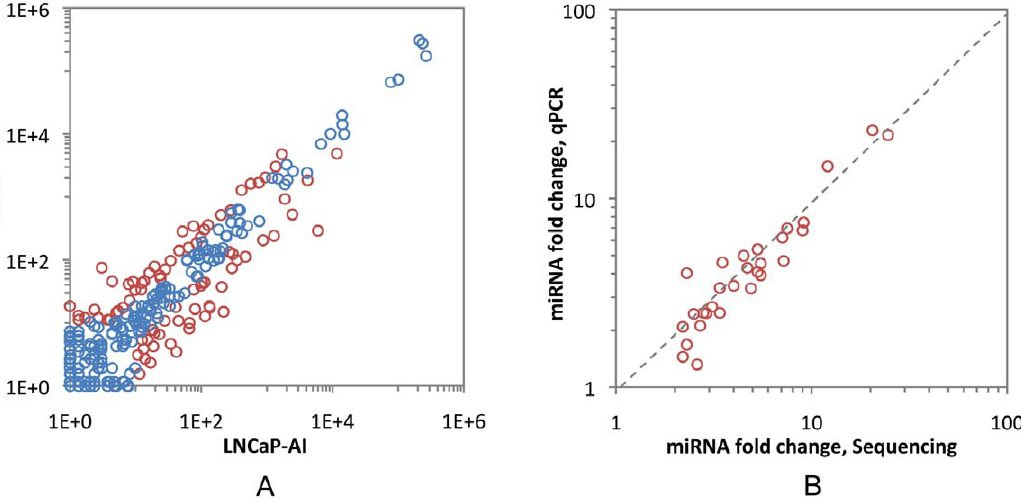
Figure 3. The miRNAs expression level and validation of the robust of Solexa sequencing with qRT-PCR analysis. (A) Expression level of LNCaP and LNCaP-AI miRNAs. The count of each miRNA was plotted after normalization. Red color circle shows differentially expressed miRNAs between LNCaP and LNCaP-AI with at least a 2-fold change and p -value below 0.001. (B) Solexa vs. qRT-PCR of miRNA fold-changes. doi:10.1371/journal.pone.0015519.g003 PLoS ONE |